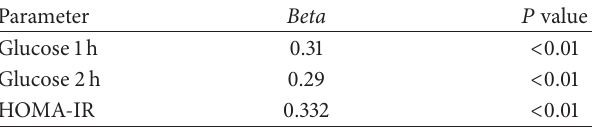
Table 3: Multivariate linear regression analysis of serum pigment epithelium-derived factor (PEDF) levels in gestational diabetes mel- litus (GDM) patients.